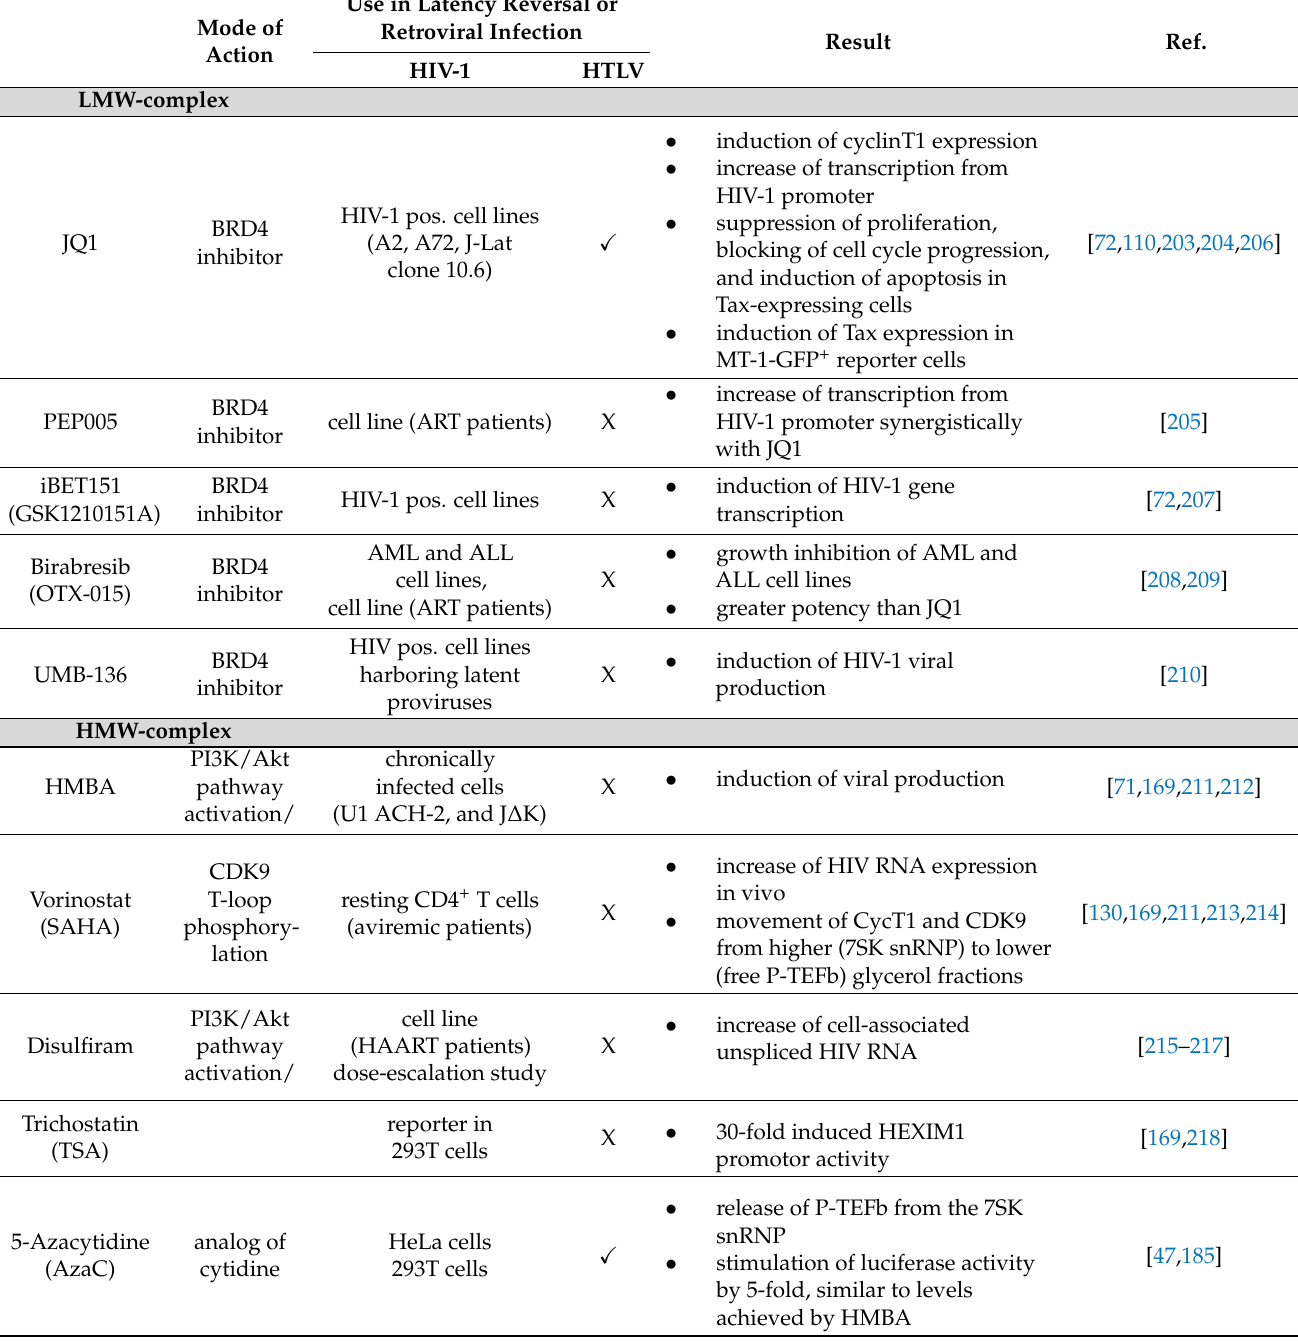
Table 2. Different P-TEFb-modulating agents that reverse retroviral